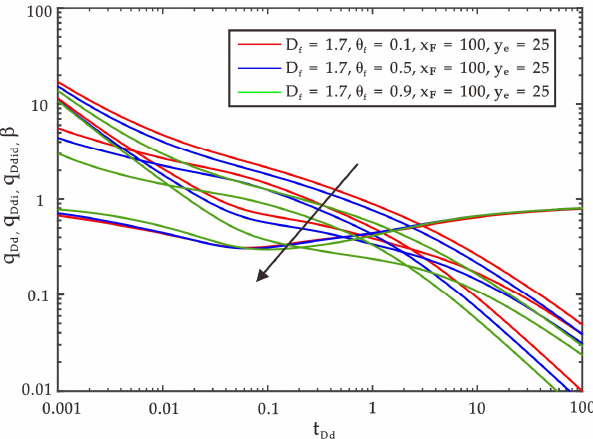
Figure 8. The sensitivity analysis of the anomalous diffusion exponent.